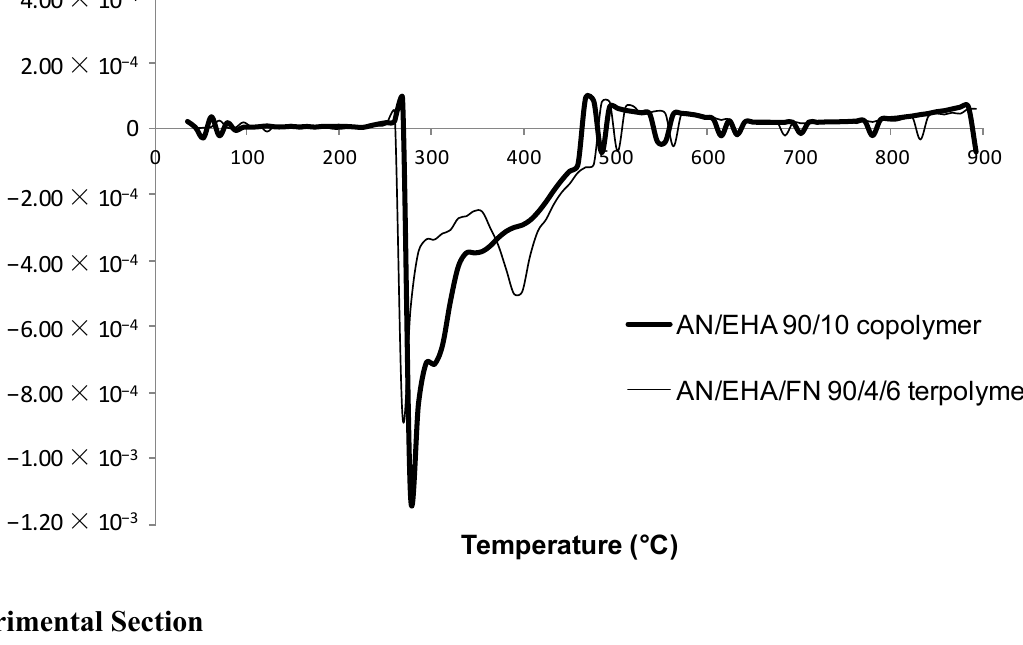
Figure 9. DTG curves of AN/EHA 90/10 copolymer and AN/EHA/FN 90/4/6